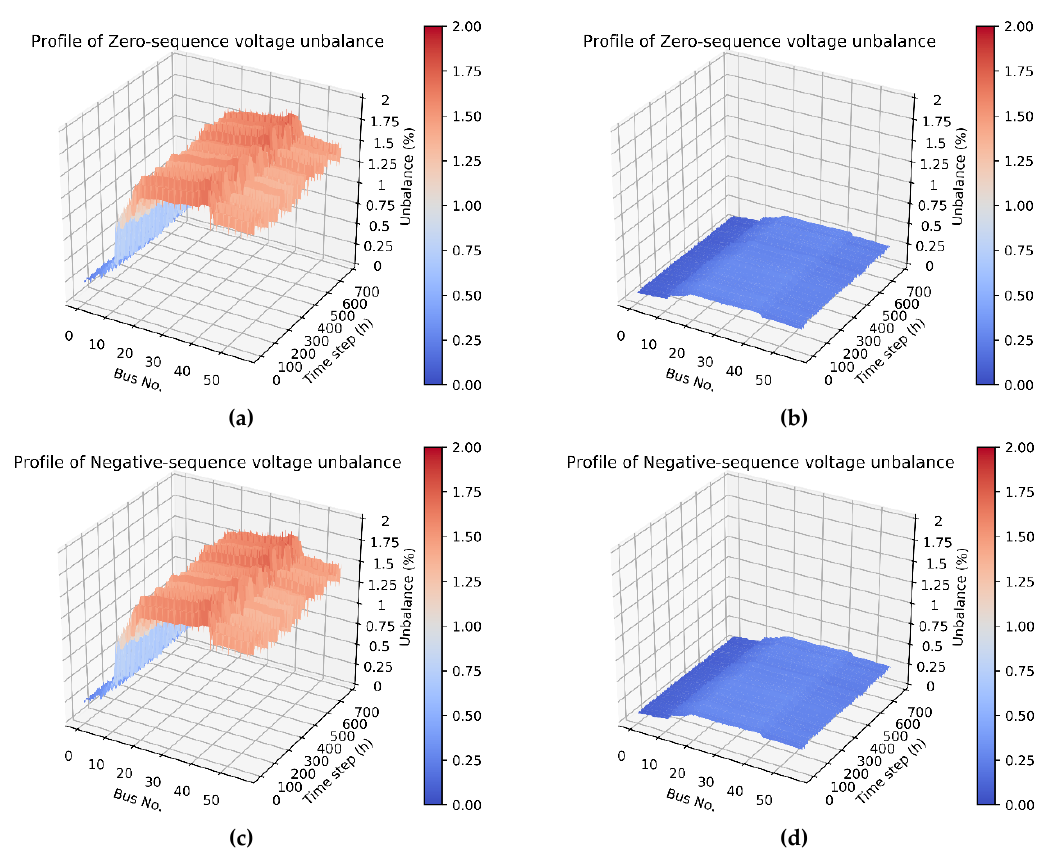
Figure 16. Zero- and negative-sequence voltage unbalance factors: ( a ) Zero-sequence: before rephasing, ( b ) Zero-sequence: after rephasing, ( c ) Negative-sequence: before rephasing, and ( d ) Negative-sequence: after rephasing.